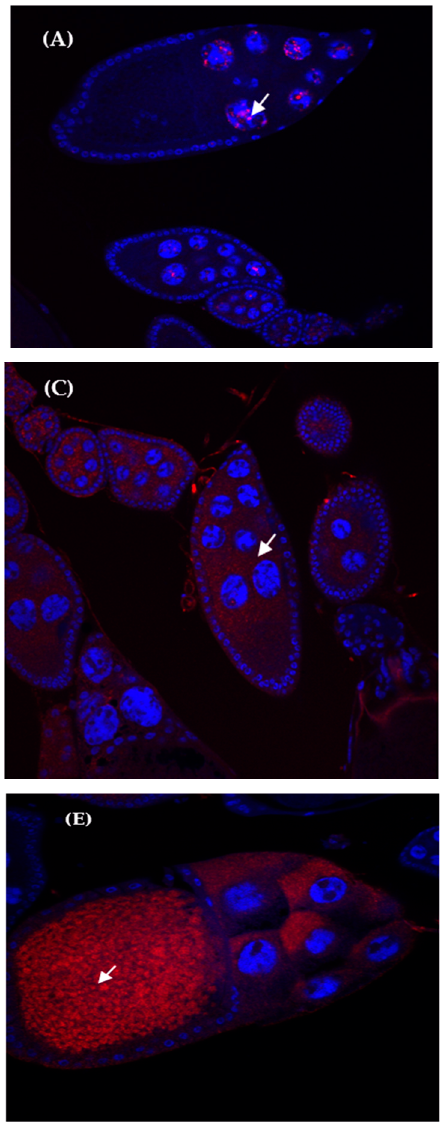
Figure 3. Fluorescent in situ hybridization (FISH) of ago3 RNA expression in ovaries. Red staining are ago3 transcripts, blue staining is DAPI (cells nuclei). Arrows mark the presence of ago3 transcripts. ( A ) positive control using Osvaldo retrotransposon probe, ( B ) negative control, ( C ) D. buzzatii , ( D ) D. koepferae , ( E ) hybrid .